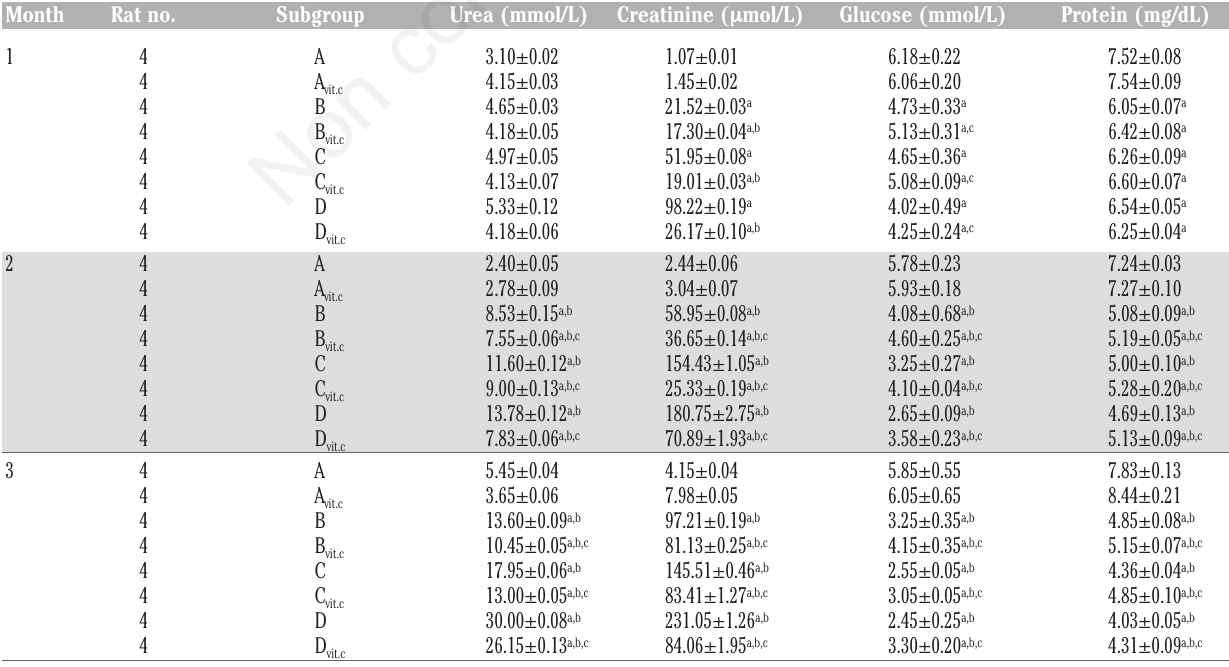
Table 5. Mean serum urea, creatinine, glucose and total protein results obtained during study period. Month Rat